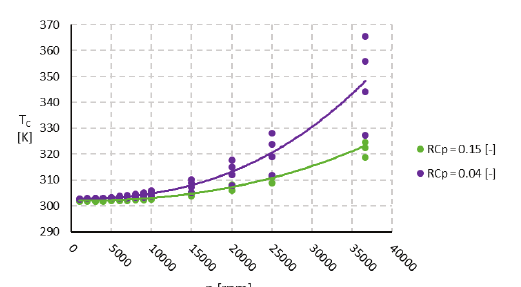
Figure 5. Static pressure trendlines